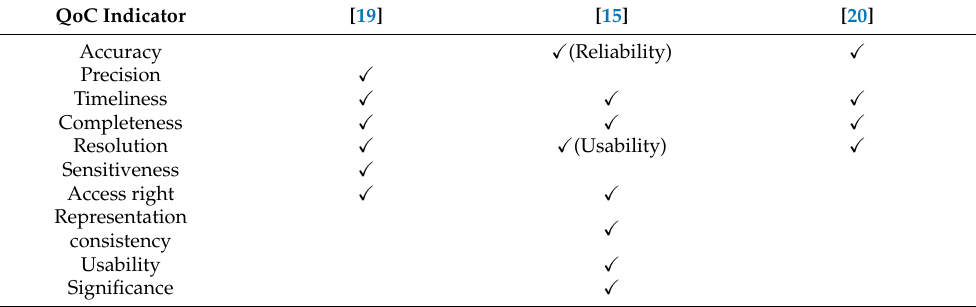
Table 5. Comparison of the QoC indicators used in different works, where, the ’ (cid:88) ’ indicate that the relative QoC indicator is discussed in the respective work. The text in the field indicates term used to address the relative QoC indicator in respective work. The blank fields indicate that the indicator was not used in that